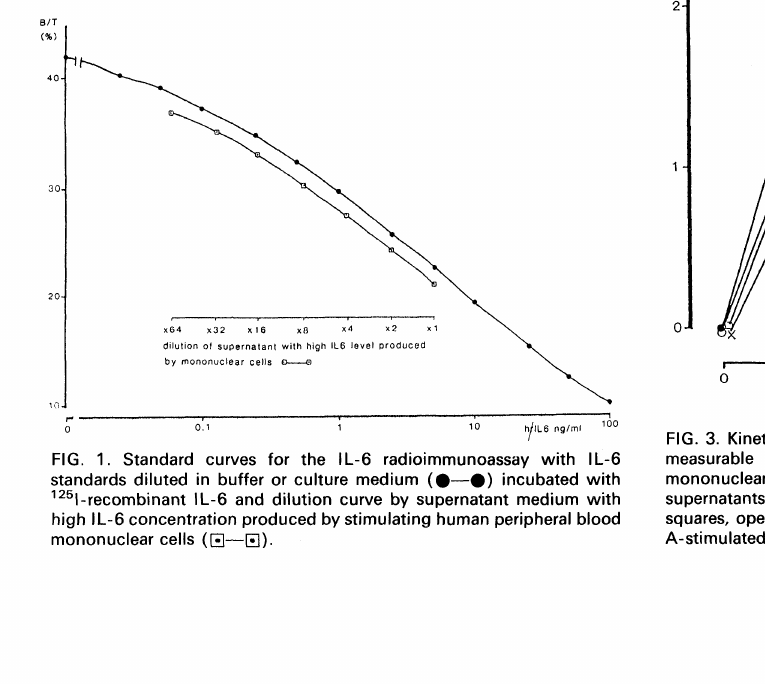
FIG. 3. Kinetics of IL-6 production. The Fig. shows IL-6 concentration measurable in supernatants of cultured human peripheral blood mononuclear cells. Each point represents mean-I-SD of IL-6 level of supernatants in ng/ml, plotted on vertical axis (n 10). Closed circles, squares, open circles and crosses represent LPS-, IgG-, PHA- and Con A-stimulated PBMC, respectively. Mediators of Inflammation.